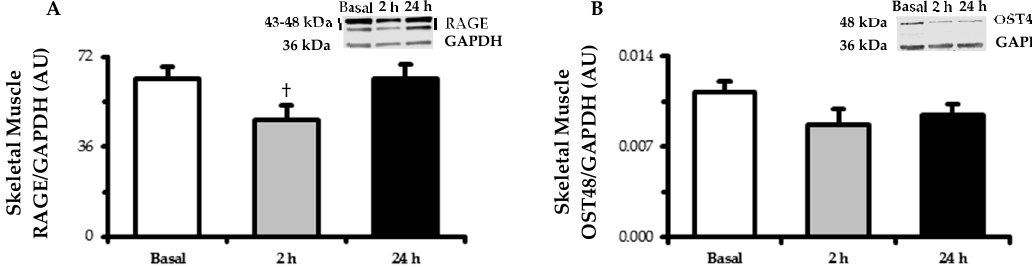
Figure 2. Skeletal muscle (m. vastus lateralis) protein expression determined by Western blot of the ( A ) RAGE and ( B ) OST48. Biopsy-derived muscle samples were taken in the basal state following an overnight fast and after 2 h and 24 h of experimental hyperglycemia (+5.4 mM above basal plasma glucose levels). Representative blot images are embedded within their respective data figures. RAGE bands (43 and 48 kDa) were quantified together. GAPDH served as a loading control. Data are means ± SE. † p < 0.10 vs. basal.